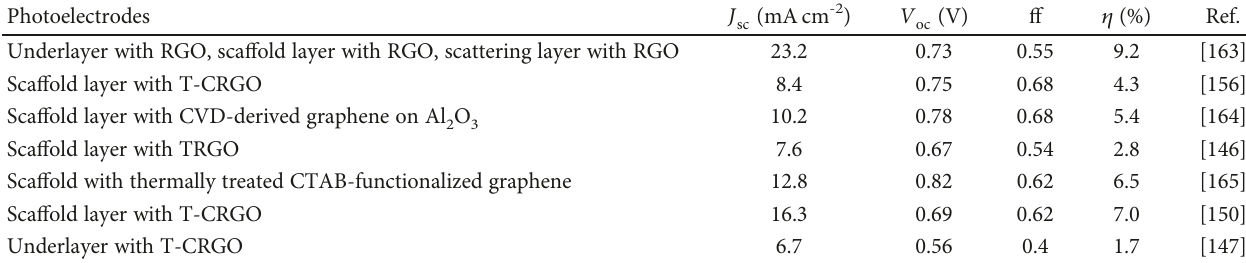
Figure 6: Illustration and performance of a solar cell based on graphene electrodes. (a) Illustration of the dye-sensitized solar cell using graphene fi lm as electrode; the four layers from bottom to top are Au, dye-sensitized heterojunction, compact TiO (b) The energy level diagram of the graphene/TiO /dye/spiro-OMeTAD/Au device. (c) I-V curve of the graphene-based cell (black) and 2 the FTO-based cell (red), illuminated under AM solar light (1 sun) [142]. Table 1: PV characteristics of DSSCs fabricated with graphene incorporated with a semiconducting layer.